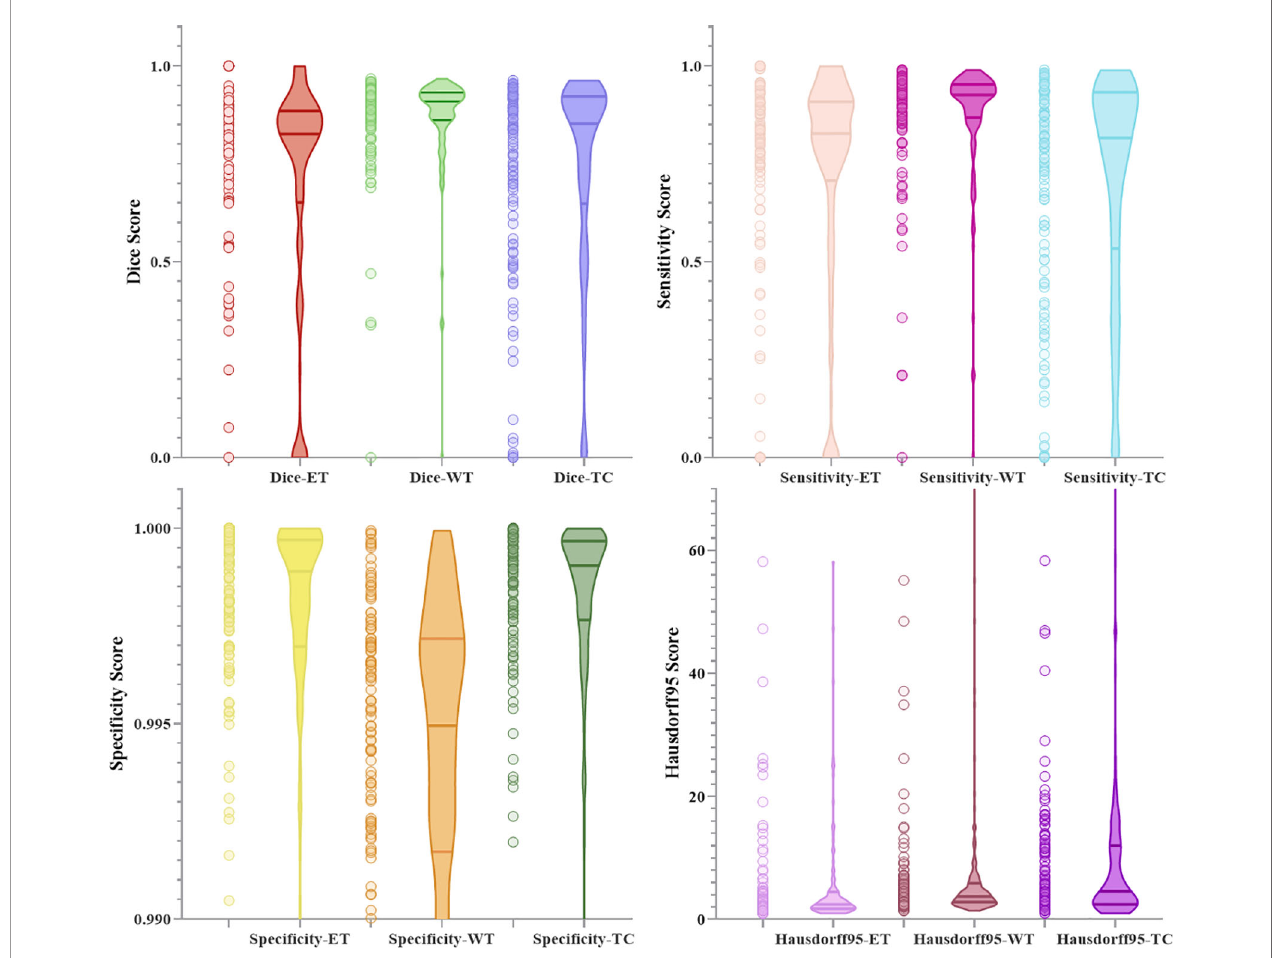
FIGURE 10 | Combination of scatters plot and box plot of the indicators for BraTS